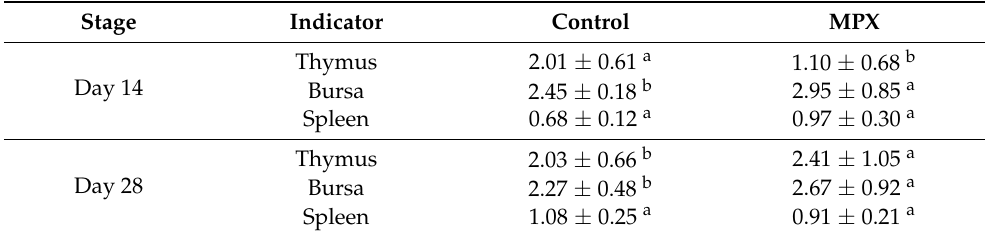
Table 5. Thymic, bursal, and spleen indices of broiler chickens fed a diet supplemented with MPX and measured at 14 d and 28 d.